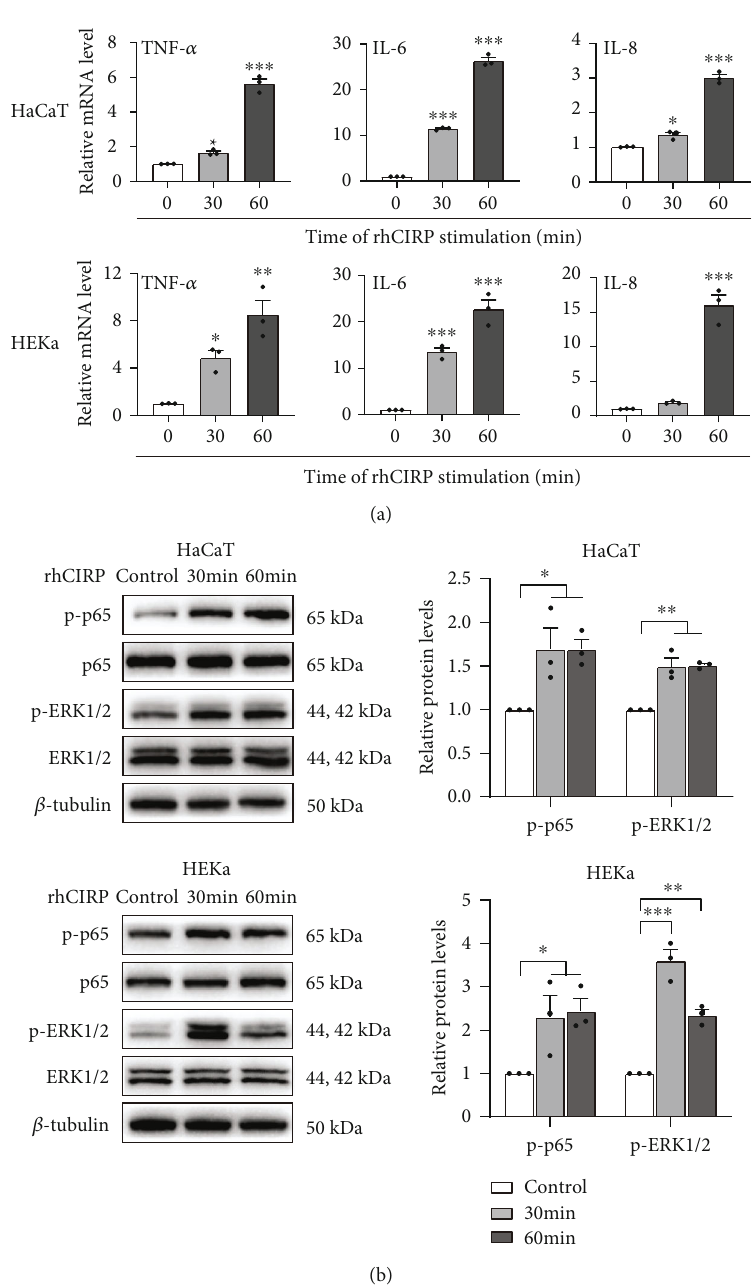
Figure 3: E ff ects of eCIRP on proin fl ammatory cytokine expression and the phosphorylation of signaling molecules. (a) rhCIRP caused the time-dependent upregulation of TNF- α , IL-6, and IL-8 in HaCaT and HEKa cells at 30 min and 60 min after 1 μ g/ml rhCIRP stimulation; the mRNA levels in the two cell lines were measured by qRT-PCR. (b) HaCaT and HEKa cells were treated with 1 μ g/ml rhCIRP for 30 and 60min, and the phosphorylation of NF- κ B p65 and ERK1/2 was analyzed by western blotting. Data are expressed as the mean ± SEM . n = 3 /group. ∗ P < 0 : 05 , ∗∗ P < 0 : 01 , and ∗∗∗ P < 0 : 001 vs.